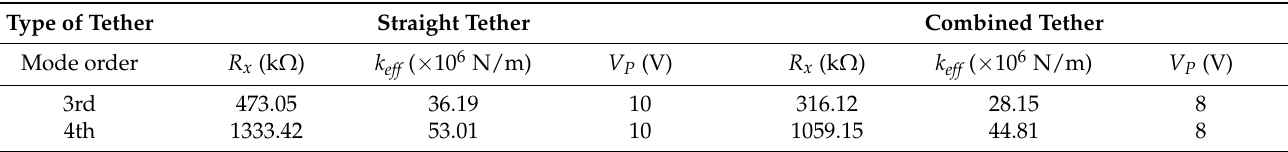
Table 6. The comparison of total stiffness of the resonator with different tethers in the 3rd and 4th